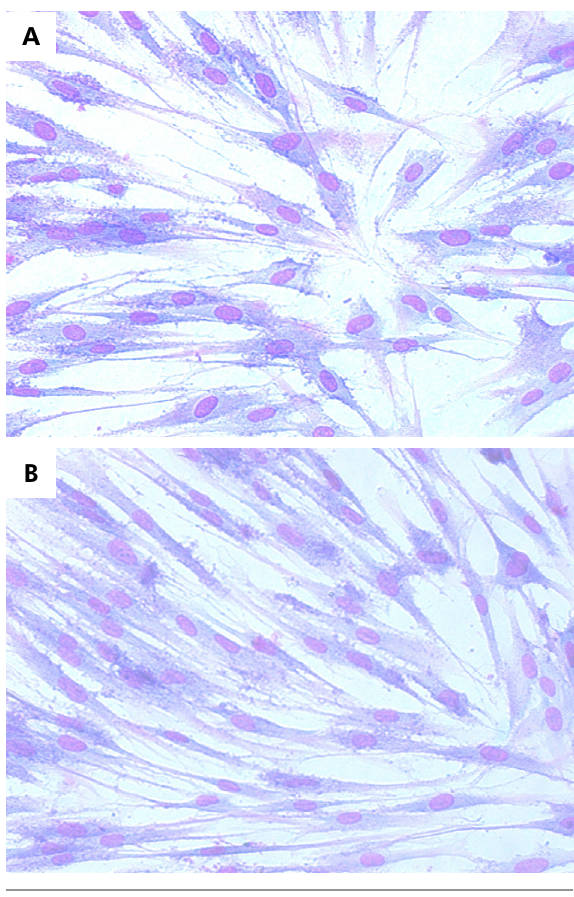
Figure 2. Illustrative phase micrographs of dental pulp cells stained with Giemsa. A) immediate culture; B) cultivation delay of 5 hours from the